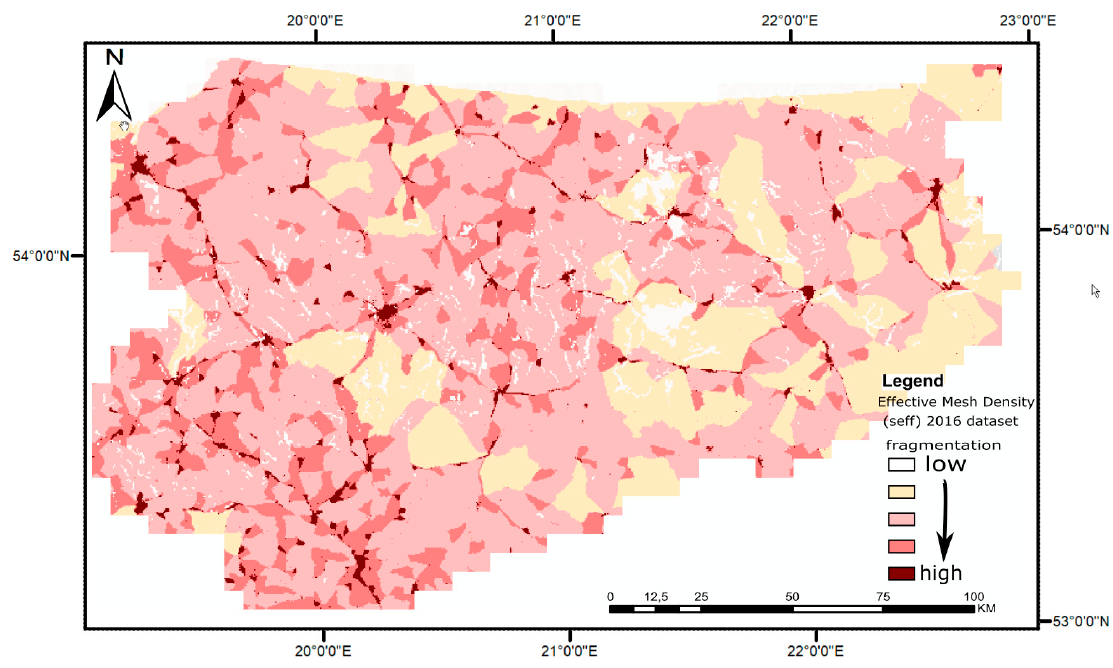
Figure 2. Fragmentation status and trends—web map generated by the European Environment Agency (EEA) .